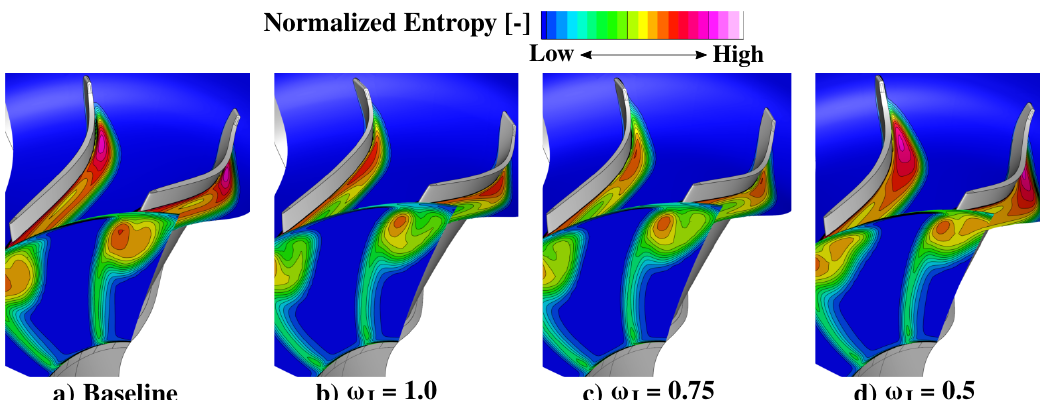
Figure 8. Comparison of normalized entropy generation between the baseline and the three optimized geometries with different weights of ω J = 1.0, ω J = 0.75, ω J =